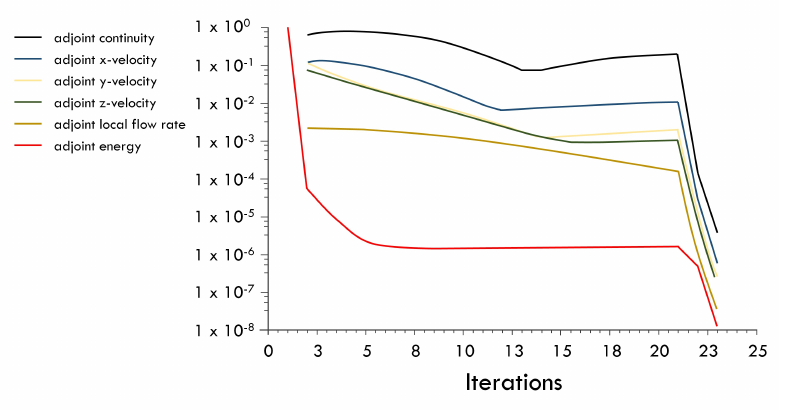
Figure 8. Residual graphs for optimization equations.